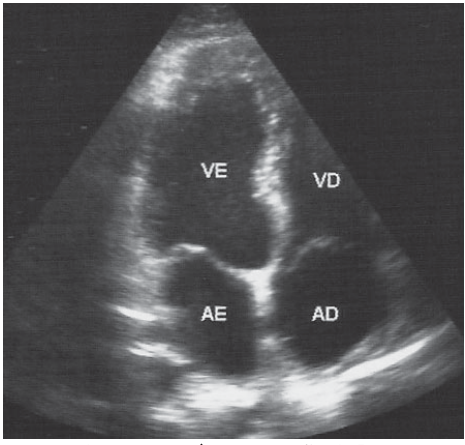
Fig. 4 - Ecocardiograma após a ressecção do